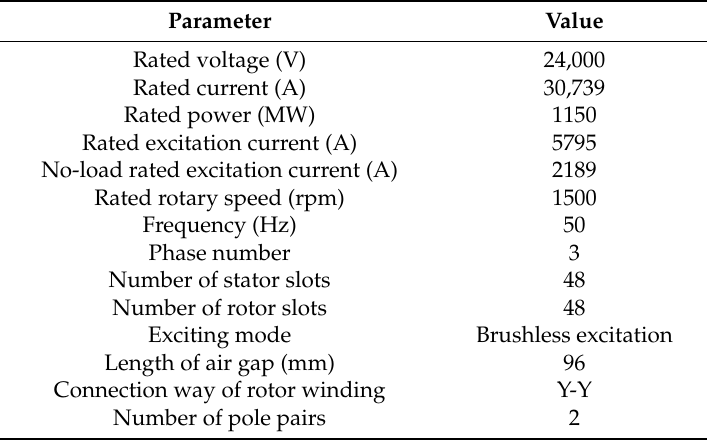
Table 1. Parameters of TA1100-78